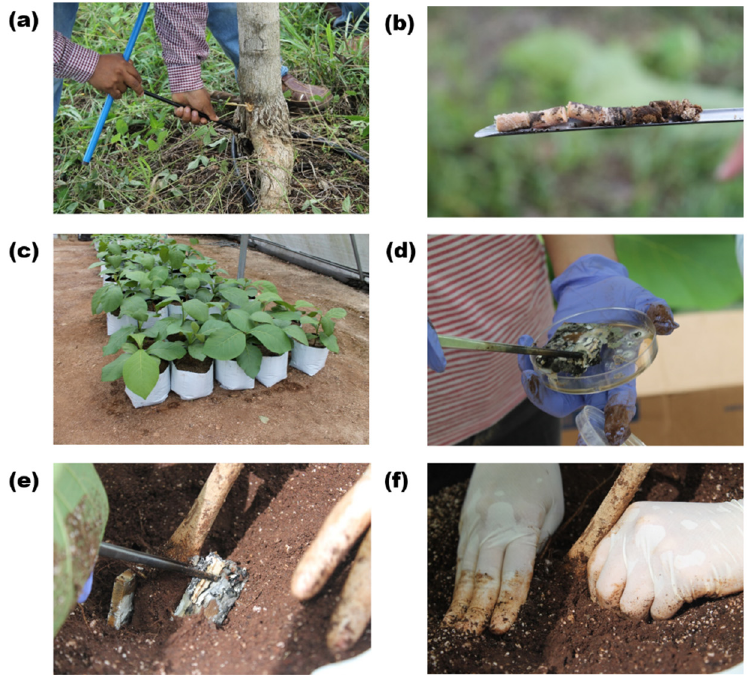
Figure 2. ( a ) Sampling tissue, in the field, from the base of the teak stem; ( b ) teak sample obtained both from the periphery and the vascular tissue; ( c ) three-month-old teak plants in greenhouse; ( d ) segment of teak tissue infected with krt-2 strain; ( e , f ) placement of the infected tissue segment in close contact with the base of the plant stem to be